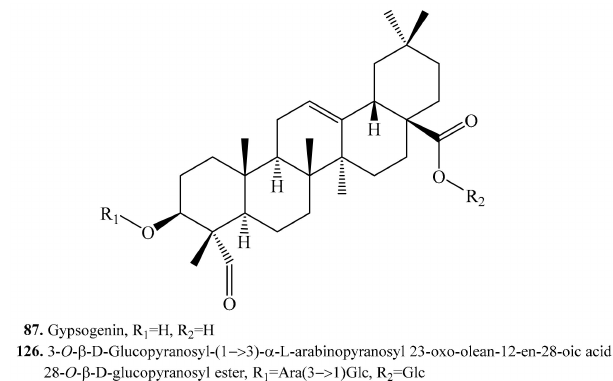
Figure 16. Structures of the gypsogenin derivatives isolated from quinoa.